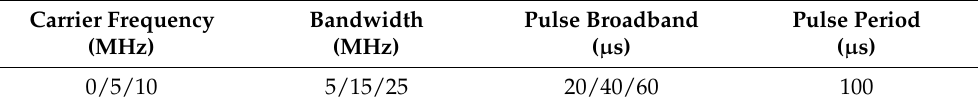
Table 3. Chirp signal parameters.